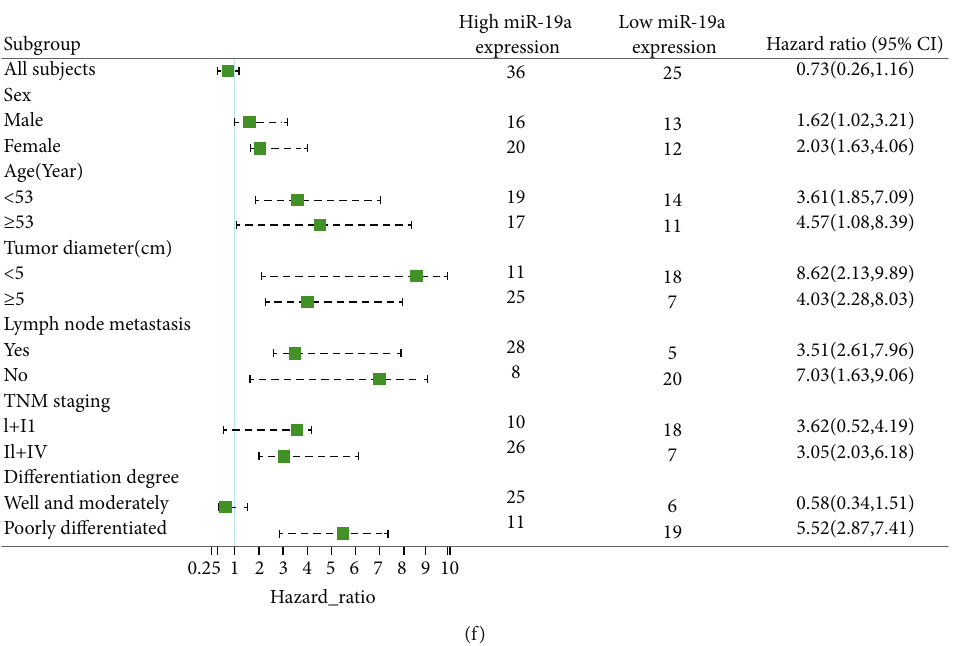
Figure 2: miR-19a is upregulated in the hypoxia-exposed CRC cells: (a) di ff erentially expressed miRNAs between CRC cells cultured under hypoxic and normoxic conditions screened using a microarray analysis; (b) expression of miR-19a in HCT116 and SW480 cells cultured under hypoxic and normoxic conditions validated by RT-qPCR ( ∗ p < 0 : 05 , two-way ANOVA); (c) expression of miR-19a in cancer and paracancerous tissues from CRC patients examined by RT-qPCR ( ∗ p < 0 : 05 , paired t -test); (d) relevance of miR-19a expression to the survival of patients ( ∗ p < 0 : 05 , Kaplan-Meier analysis); (e) relevance of miR-19a expression to the clinical characteristics of patients; (f) expression of miR-19a in HCT116 and SW480 and in normal NCM460 cells determined by RT-qPCR ( ∗ p < 0 : 05 , one-way ANOVA). Data were presented as the mean ± SD from three independent